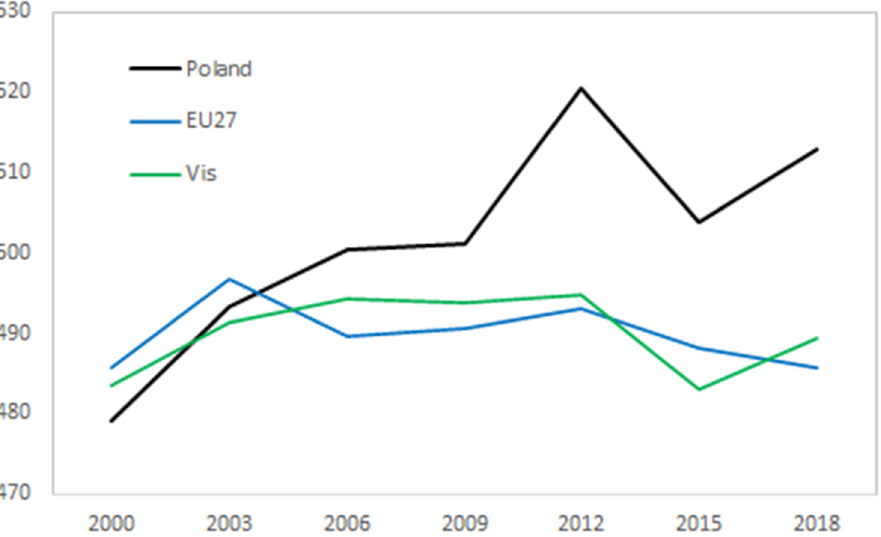
Figure 8. Dynamics of educational background. Results from the PISA 2000–2018 study. Source of data: EUROSTAT [38].